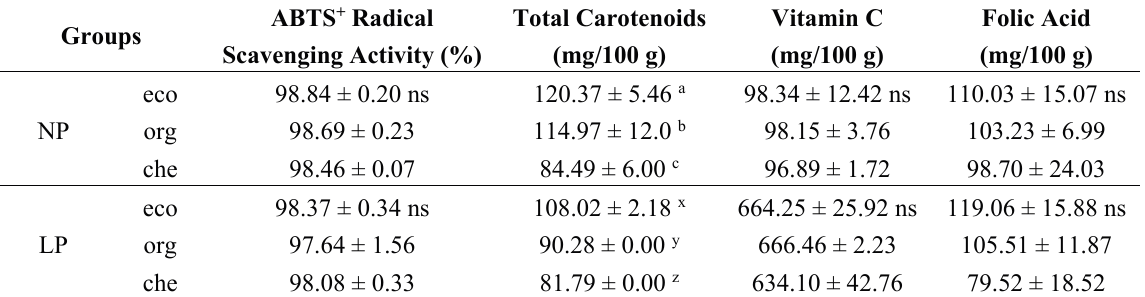
Table 3. ABTS + radical scavenging activity, total carotenoids and vitamins in chicory. Groups